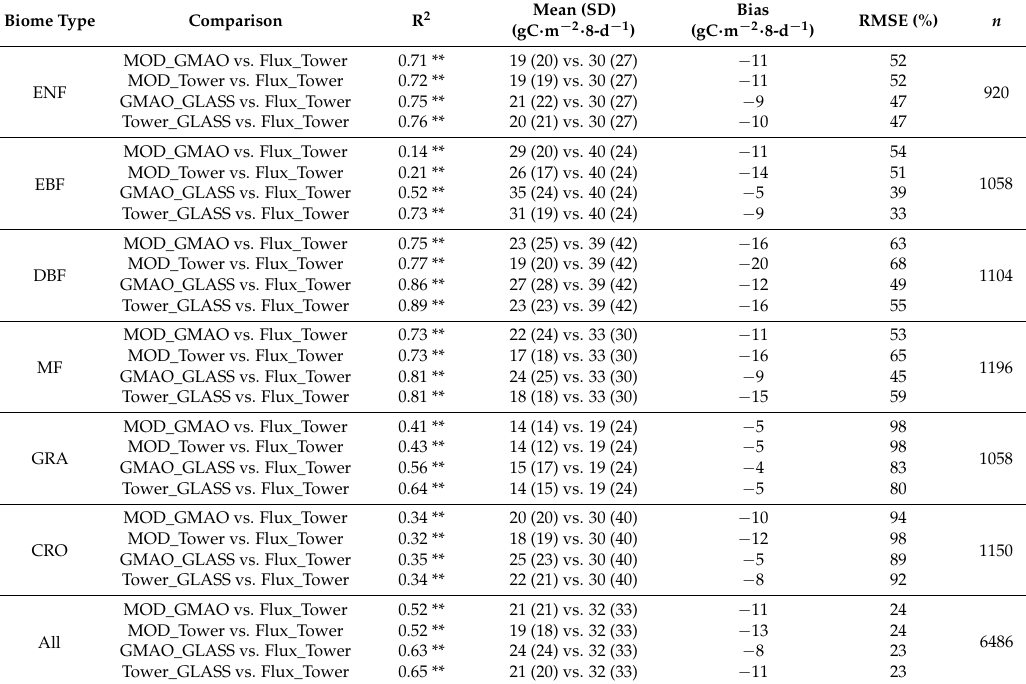
Table 2. Biome-based comparison of eight-day GPP derived from the site estimates with those derived from the MODIS algorithms (MOD_GMAO GPP, MOD_Tower GPP, GMAO_GLASS GPP and Tower_GLASS GPP). ENF: evergreen needleleaf forests; EBF: evergreen broadleaf forests; DBF: deciduous broadleaf forests; MF: mixed forests; GRA: grasslands; CRO: